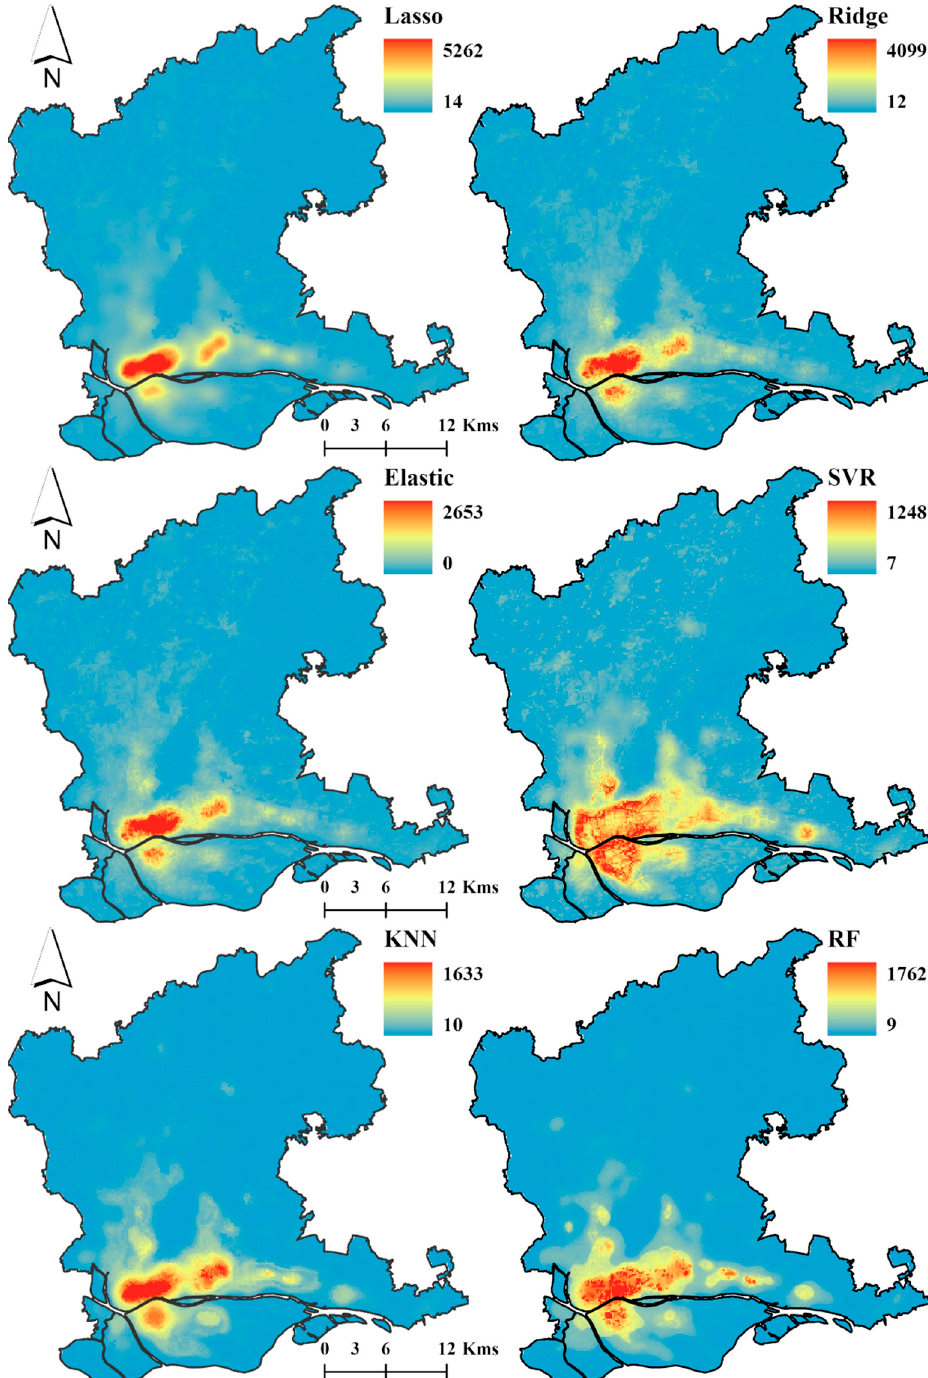
Figure 3. Gridded population maps derived from twelve regression models.